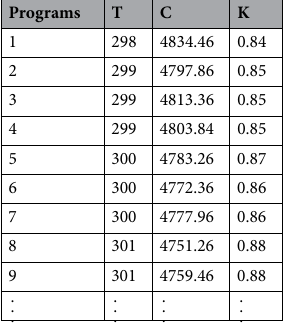
Table 6. Target optimal value and corresponding solution.